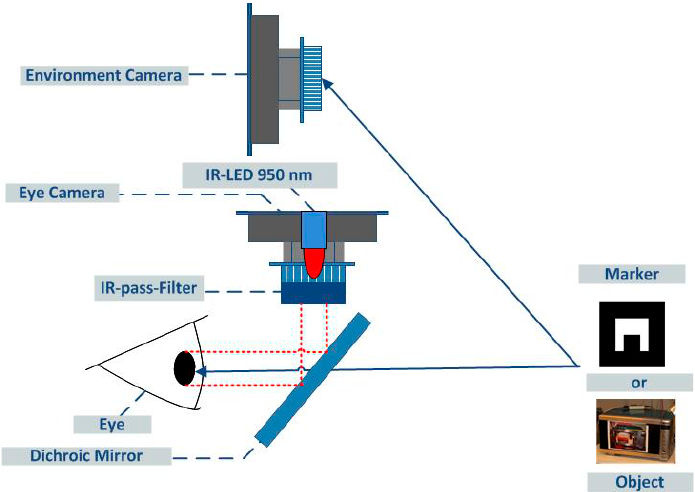
Figure 2. Layout of eye tracker and environmental camera to recognize gaze direction and objects to be controlled.